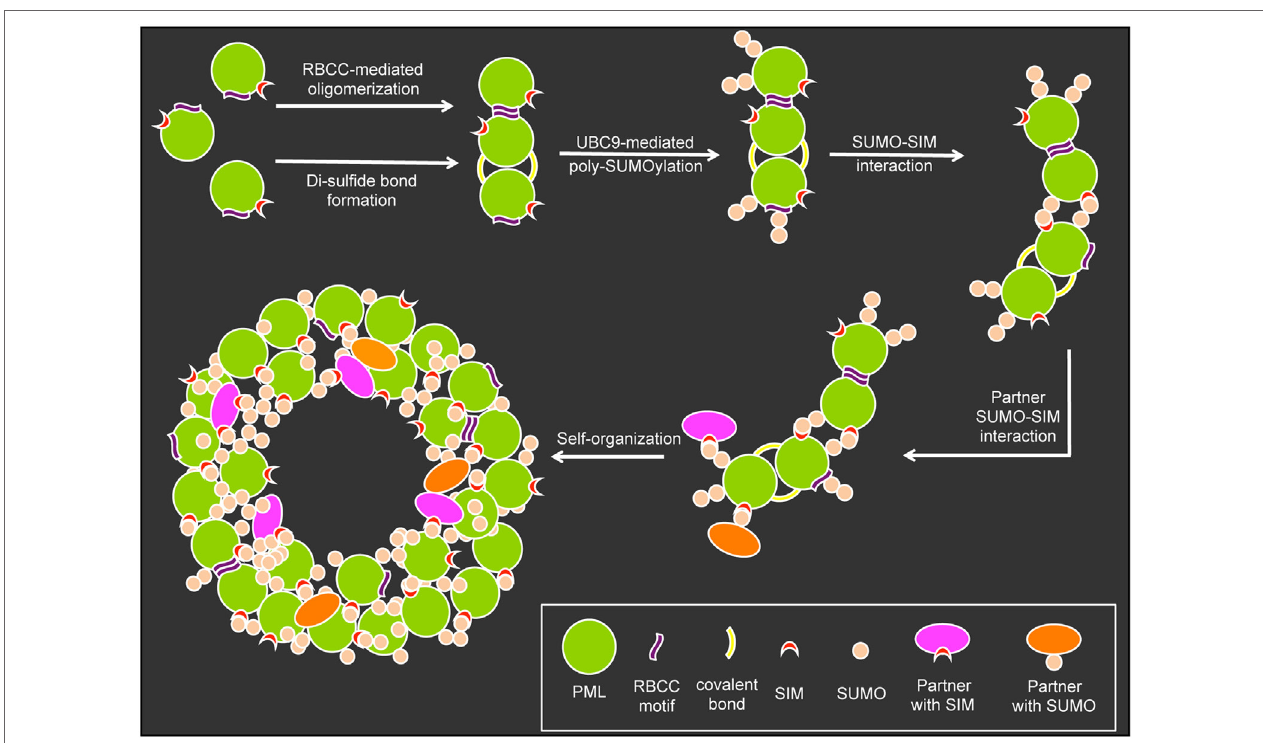
FigURe 3 | Assembly of promyelocytic leukemia (PML) nuclear bodies. The assembly of PML nuclear bodies is initiated by oligomerization of non-SUMOylated PML monomers. Oligomerization occurs via weak non-covalent interactions through the RBCC motif and covalent di-sulfide bonds between cystein residues. The E2-small ubiquitin-related modifier (SUMO) ligase UBC9 then promotes (poly-)SUMOylation of the PML moieties which allows for multiple SUMO–SUMO interacting motifs (SIM) interaction possibilities to form larger aggregates. Binding partners carrying SIMs and or SUMO residues can bind to the preassembled aggregates to form a normal PML body based on